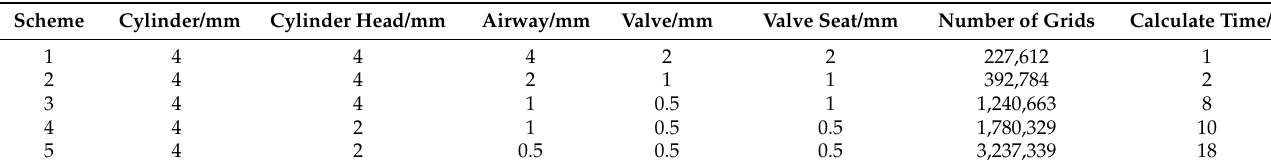
Table 2. Meshing schemes for different areas.